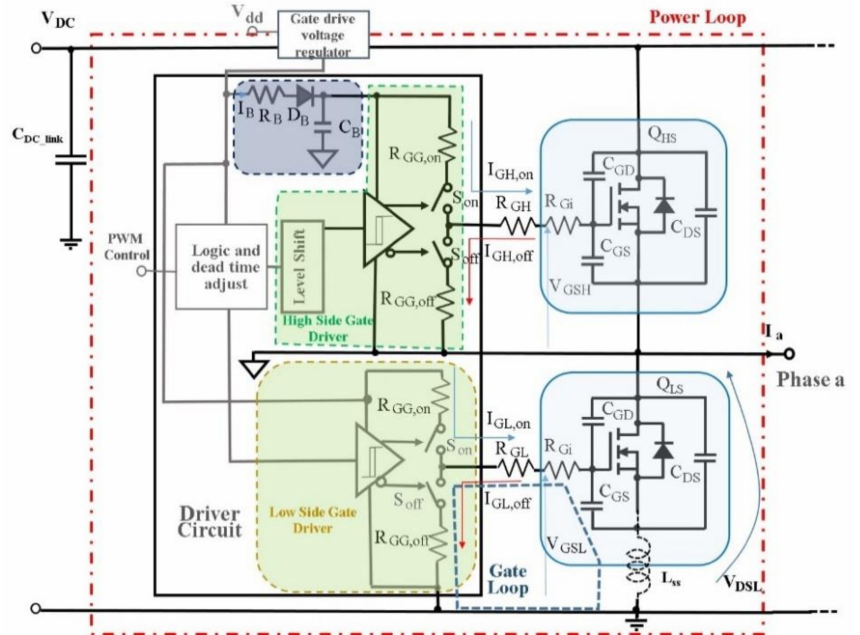
Figure 8. Schematic of the driver circuit and power stage of a switching leg (phase